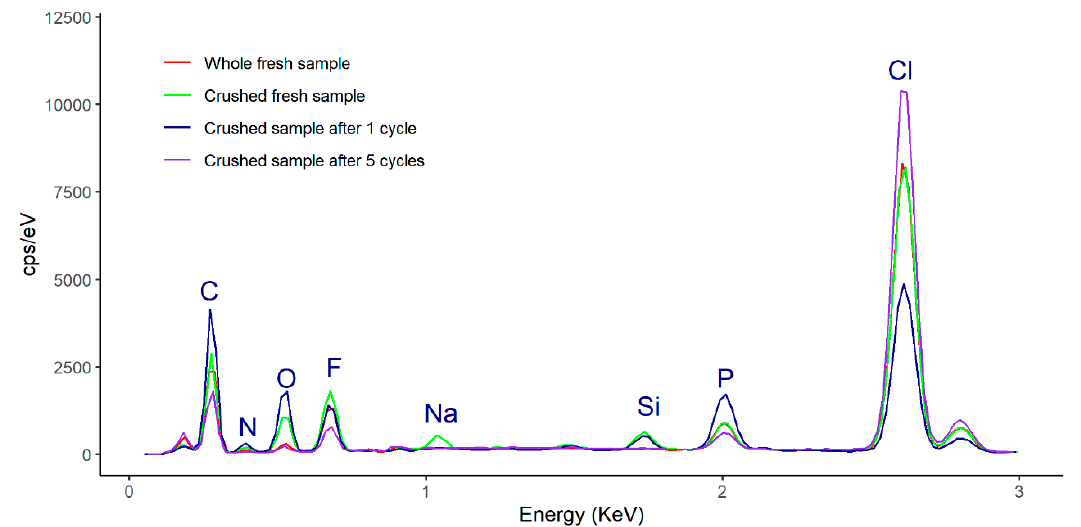
Figure 11. EDX spectra of the sample prepared with PVC and ionic liquids [Omim] [PF 6 ] in the absence of enzyme: whole fresh sample (red line), crushed fresh sample (green line), crushed sample after 1 cycle (blue line), and crushed sample after 5 cycles (purple line).